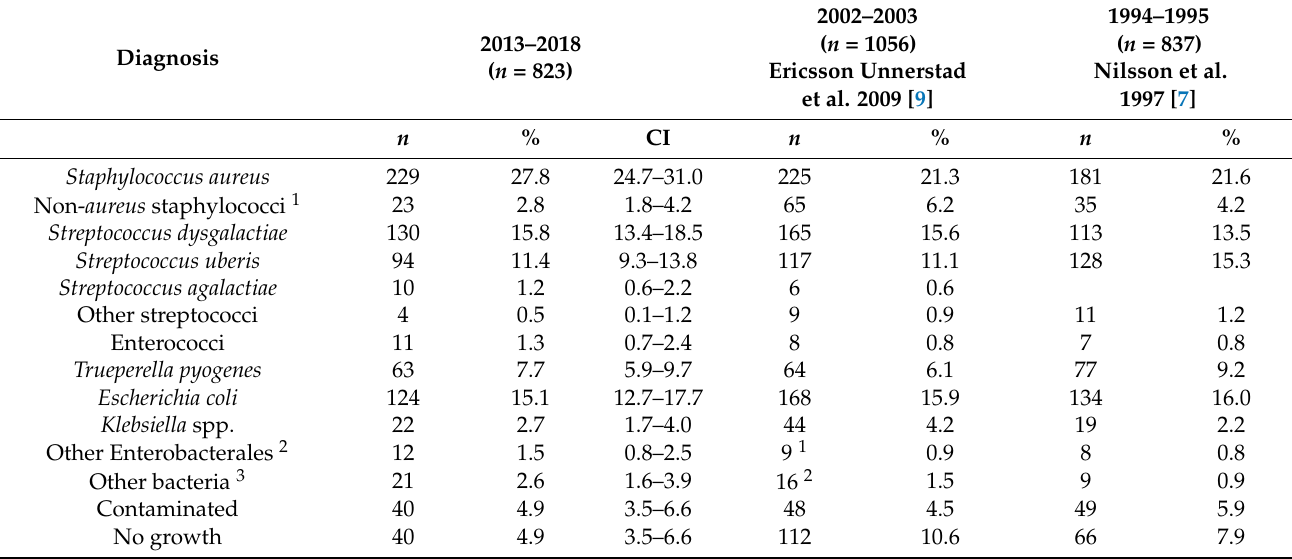
Table 1. Distribution of 823 microbial diagnoses from 755 udder quarters from cows with clinical mastitis (per cent, 95% confidence interval (CI) and number of